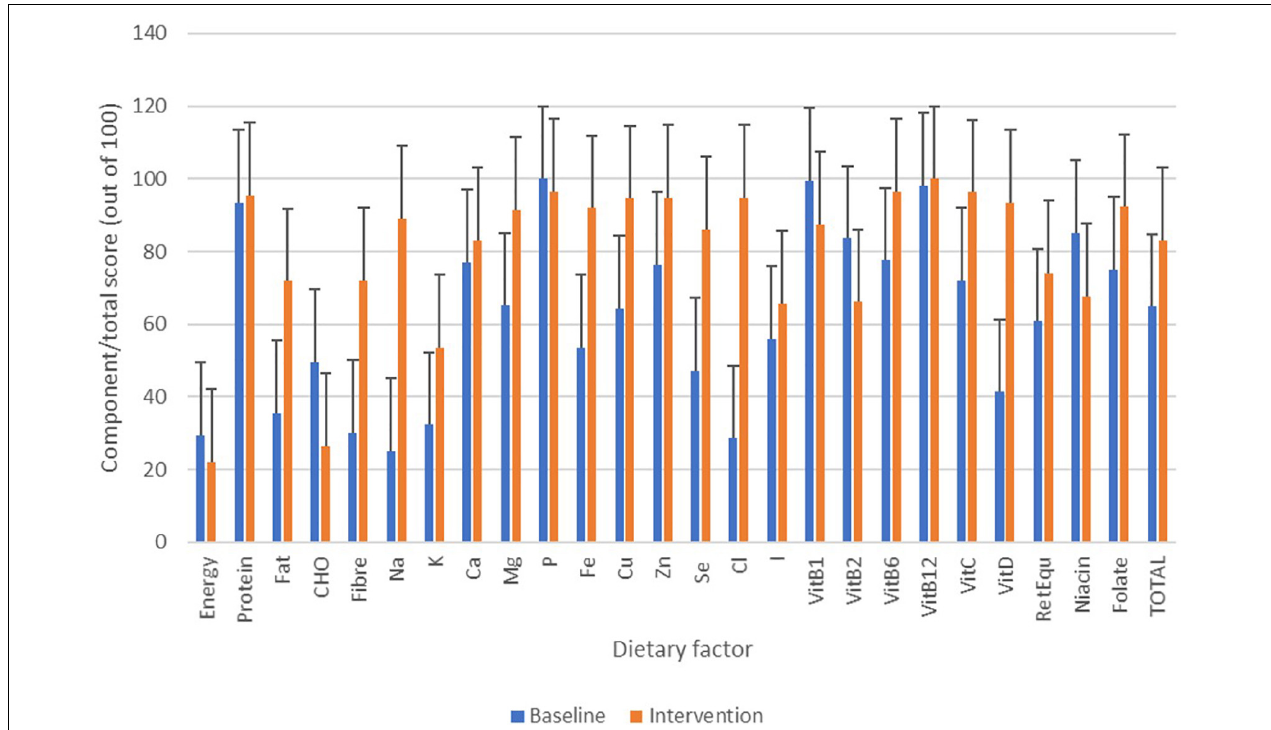
FIGURE 10 | Changes in micronutrient/energy intake based on food diary data over the course of the study. Bars in blue show micronutrient/energy intake from the baseline week with bars in orange showing micronutrient/energy intake from Huel diet